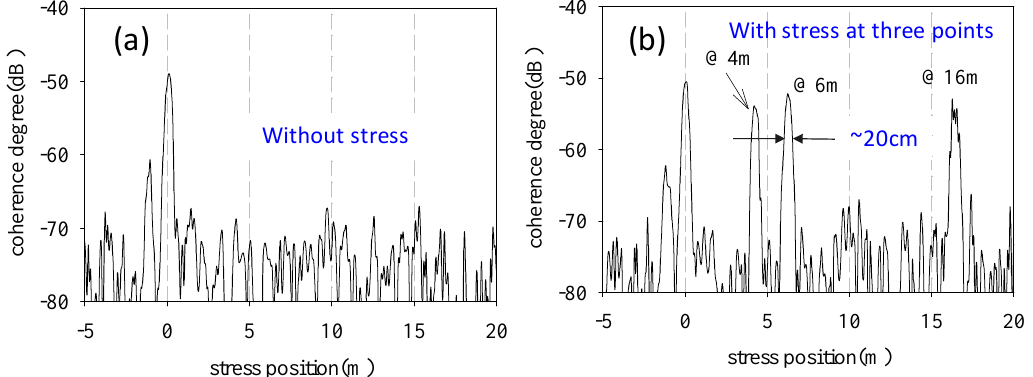
Figure 16. Experimental results of the lateral force distribution measurement along a polarization-maintaining optical fiber [33]. System output ( a ) for no lateral force applied, and ( b ) for lateral force applied at three points along the fiber.